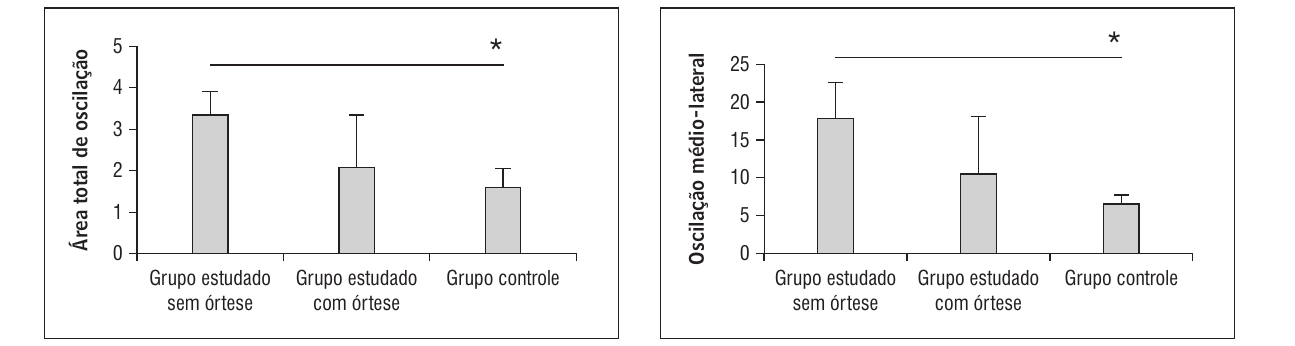
Figura 2 - Variação da oscilação do COP, no sentido médio-la- teral entre os grupos (GE sem e com órtese e GC) Legenda: *(p < 0,01). Fonte: Dados da